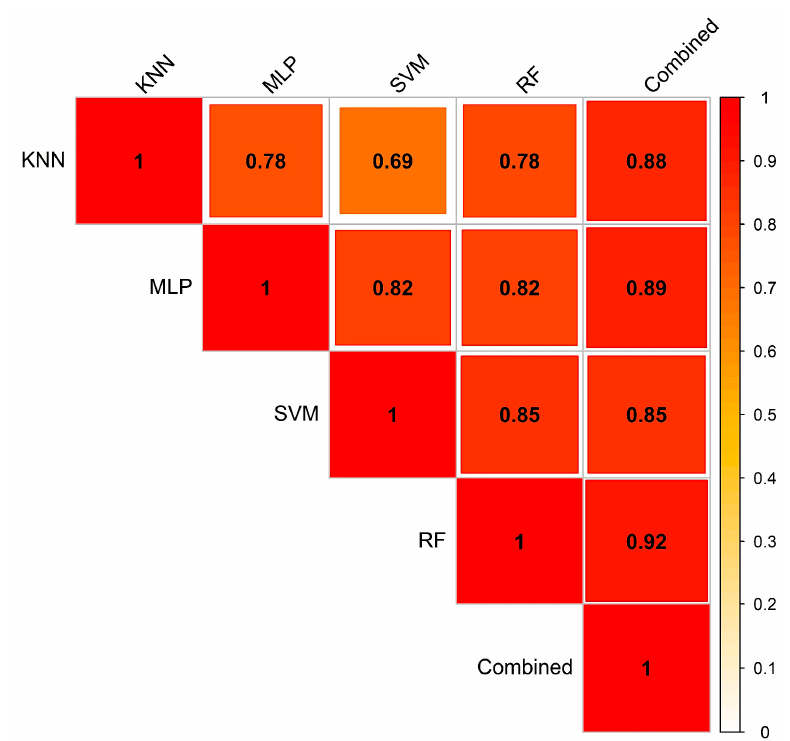
Figure 8. Correlogram to show the agreement between the five landslide susceptibility models: K-Nearest Neighbor (KNN), Multi-Layer Perceptron (MLP), Random Forest (RF), Support Vector Machine (SVM), and combined model.